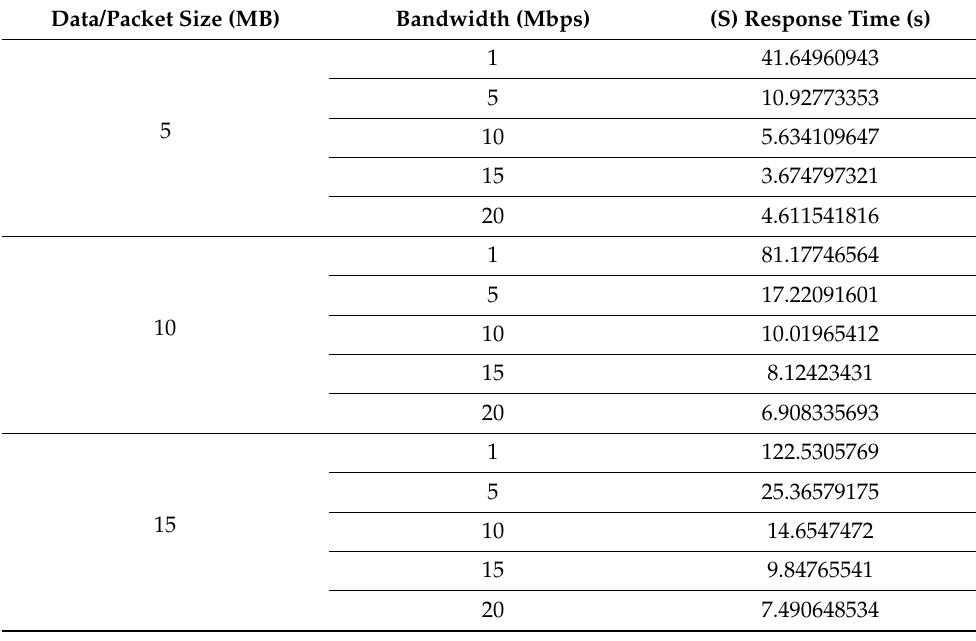
Table 4. HMS To FTP (Internet).